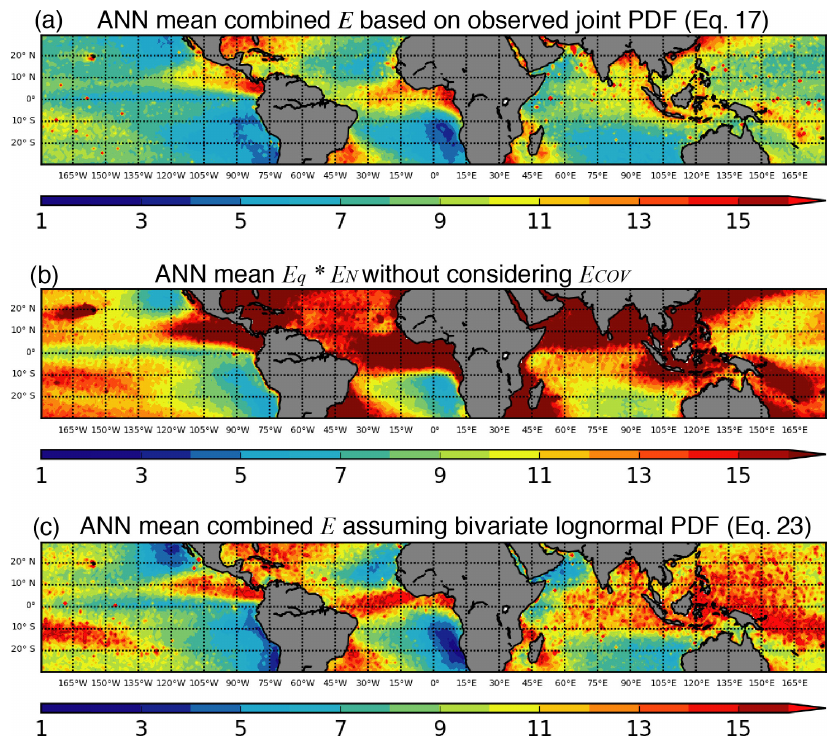
Figure 11. The combined enhancement factor derived (a) based on Eq. (17) from the observed joint PDF of LWP and CDNC, (b) assuming that subgrid variations of LWP and CDNC are uncorrelated, i.e., E q · E N only, and (c) based on Eq. (23) assuming that the subgrid LWP and CDNC following the bivariate lognormal